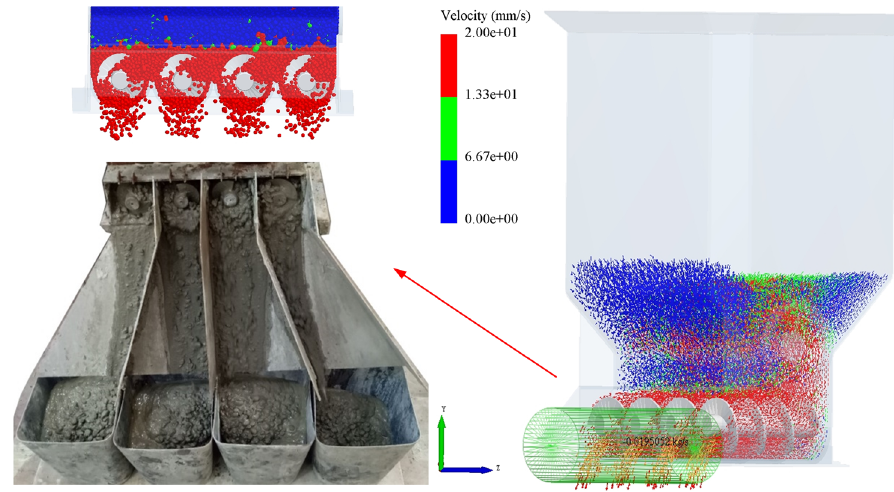
Figure 16: Concrete discharging behavior in the screw conveyor experiment ( left ) and the DEM ( right )